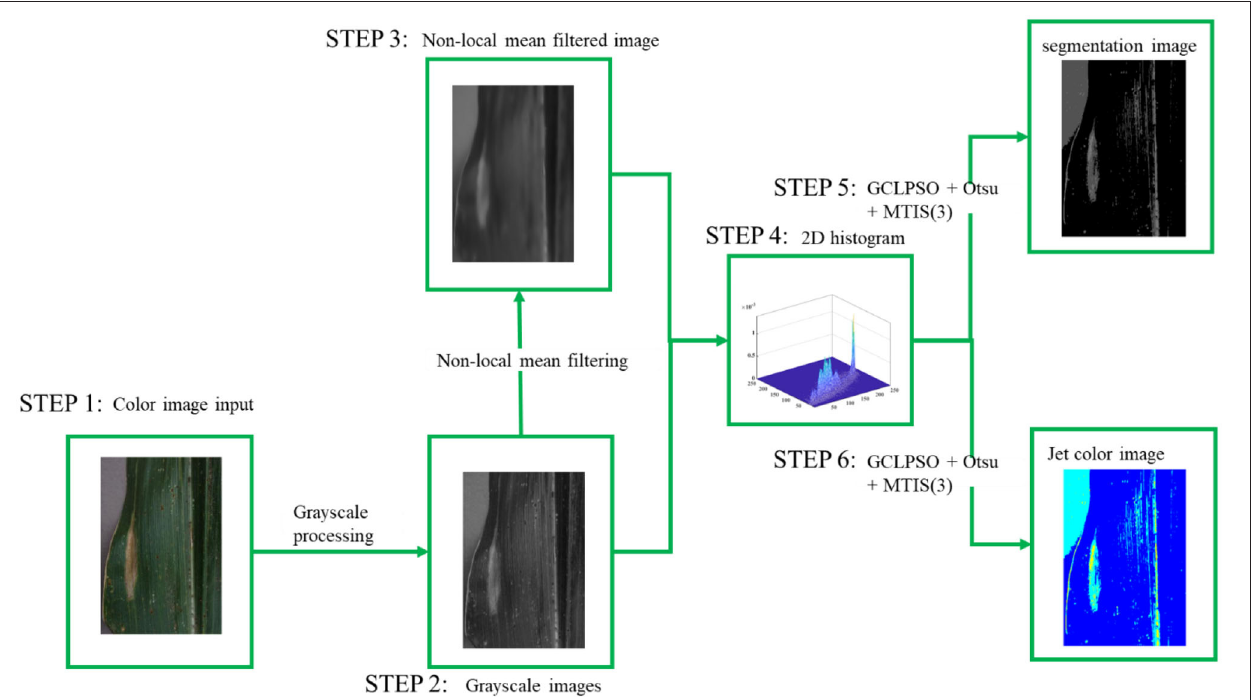
FIGURE 1 | Flowchart of multi-threshold image segmentation of maize diseases using GCLPSO + Otsu.